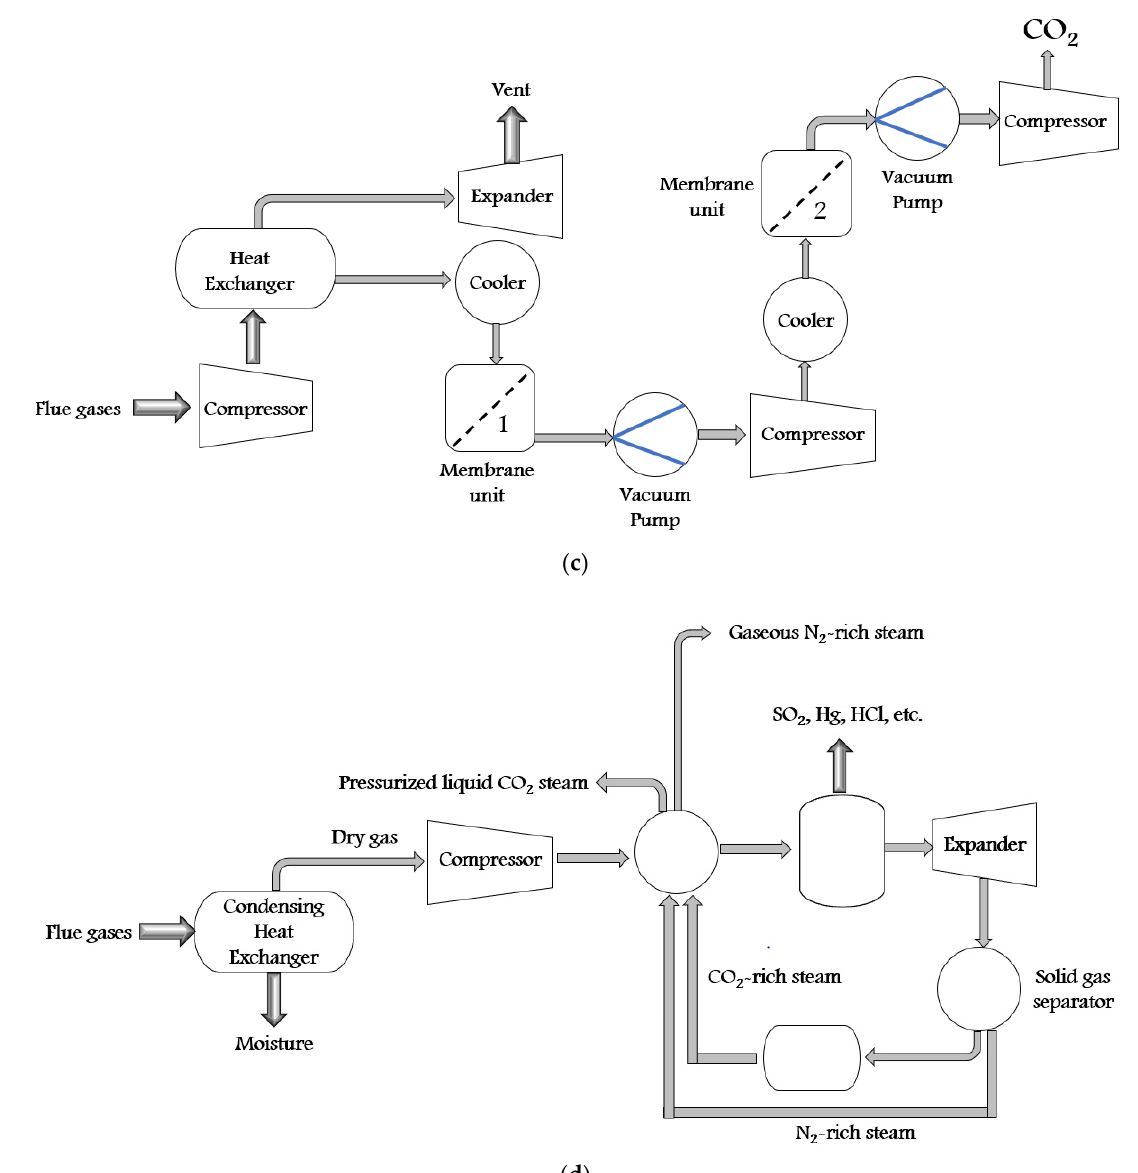
Figure 6. The schematic diagram of CO 2 capture by ( a ) solvent technology, ( b ) solid sorbent tech- nology, ( c ) membrane technology, and ( d ) cryogenic distillation